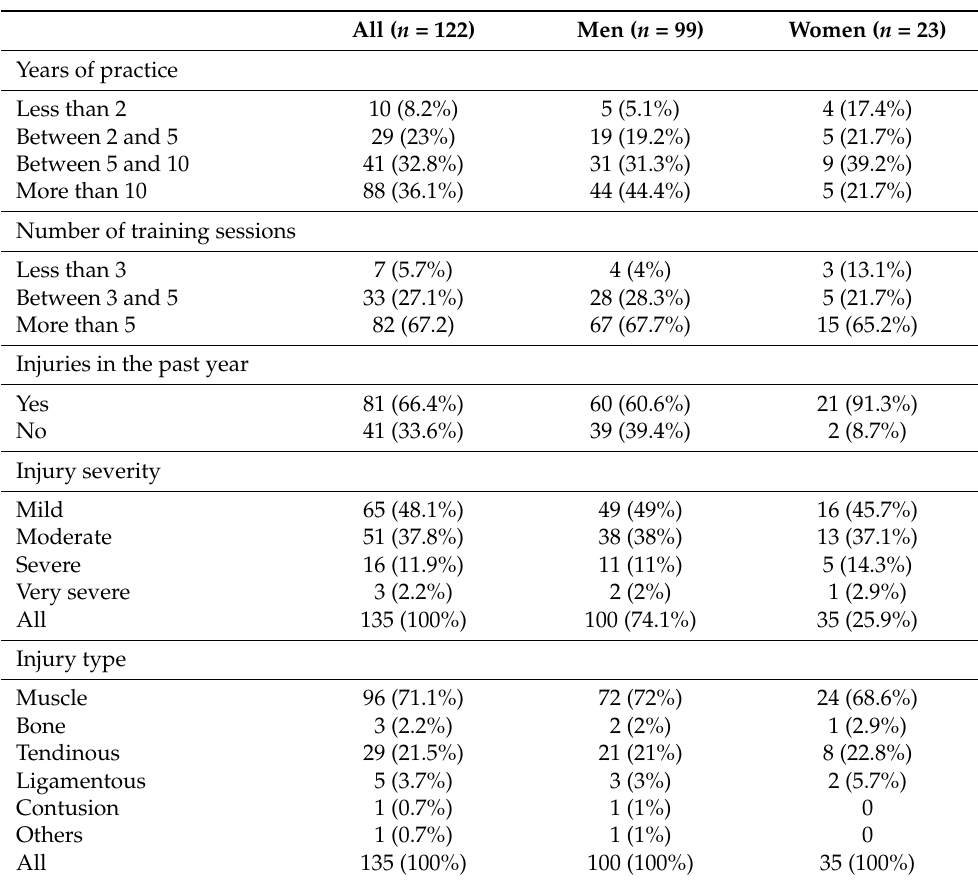
Table 1. Descriptive analysis of the sample.